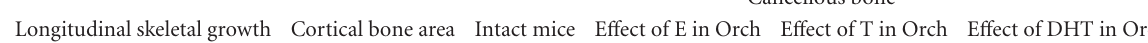
Table 4: Summary of the skeletal phenotypes in mice with di ff erent sex steroid-related gene inactivations.